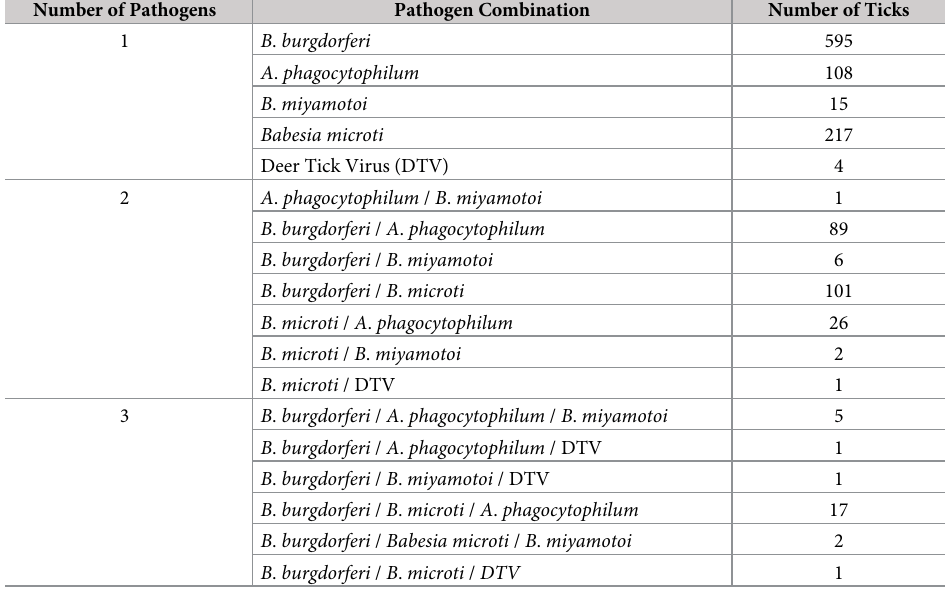
Table 3. Coinfections observed in I . scapularis . A list of the number of single-pathogen infections compared to the various combinations observed with two or three pathogens. No polymicrobial infections with greater than three path- ogens were observed in this set of ticks. The majority of coinfections were associated with B . burgdorferi . Number of Pathogens Pathogen Combination Number of